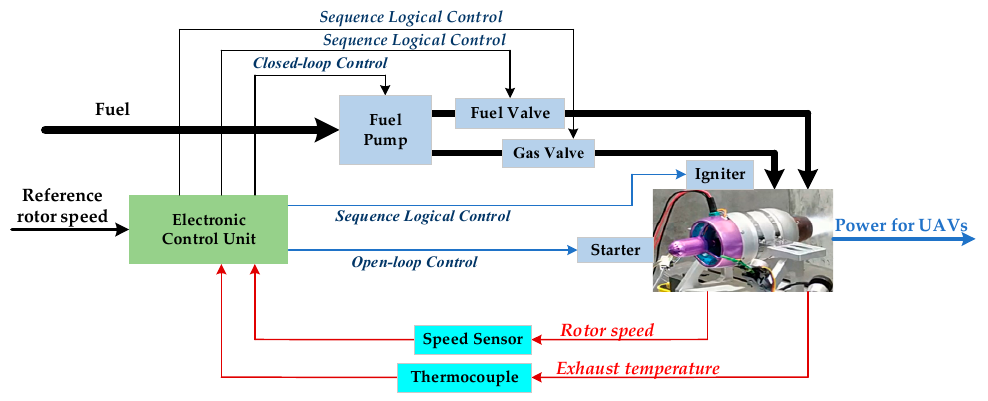
Figure 4. The control system for MTE.